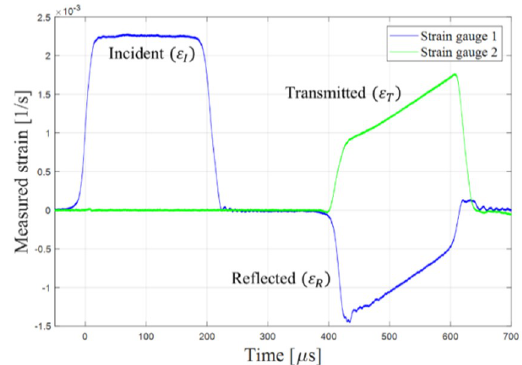
Figure 4. Typical strain signals measured by strain gauges on incident bars (blue) and transmitted bars (green).